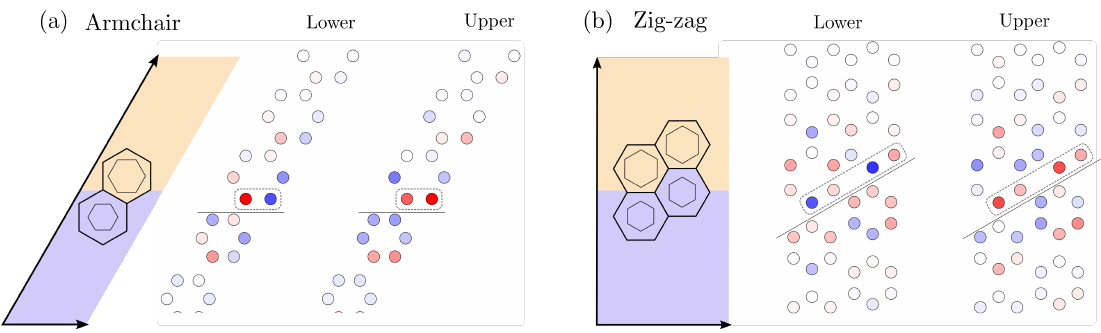
Figure A3. Hybridisation of NPs at interface: ( a ) Armchair interface, ( b ) Zig-zag interface.